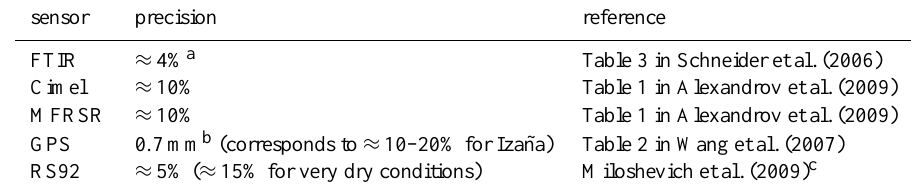
Table 1. Theoretically estimated PWV precision of FTIR, MFRSR, Cimel, GPS, and